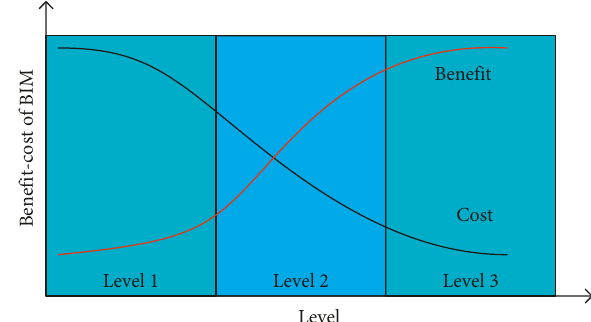
Figure 1: Benefit-cost curve of